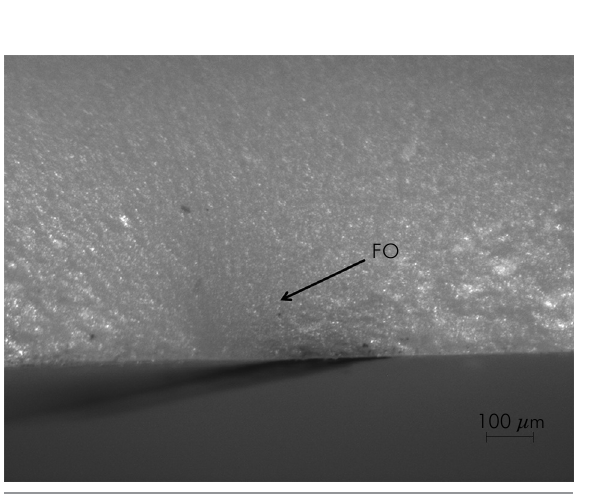
Figure 3. Representative image (90x magnification) of the fracture origin (FO) located on the surface of the sample (Group 120A).